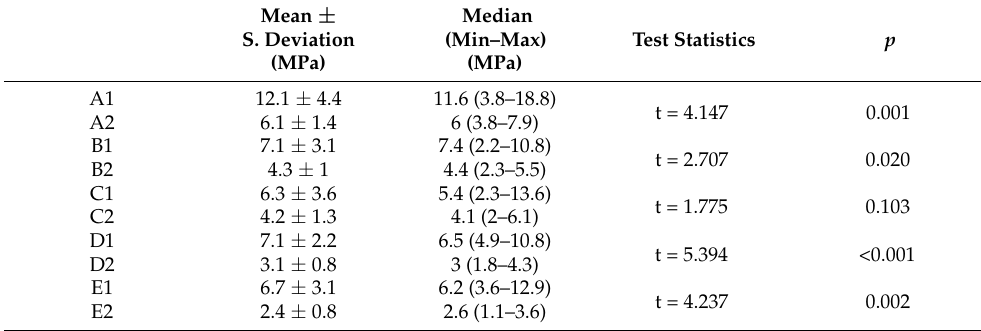
Table 3. Shear bond strength comparisons of laminate veneers and composite resins in each groups.